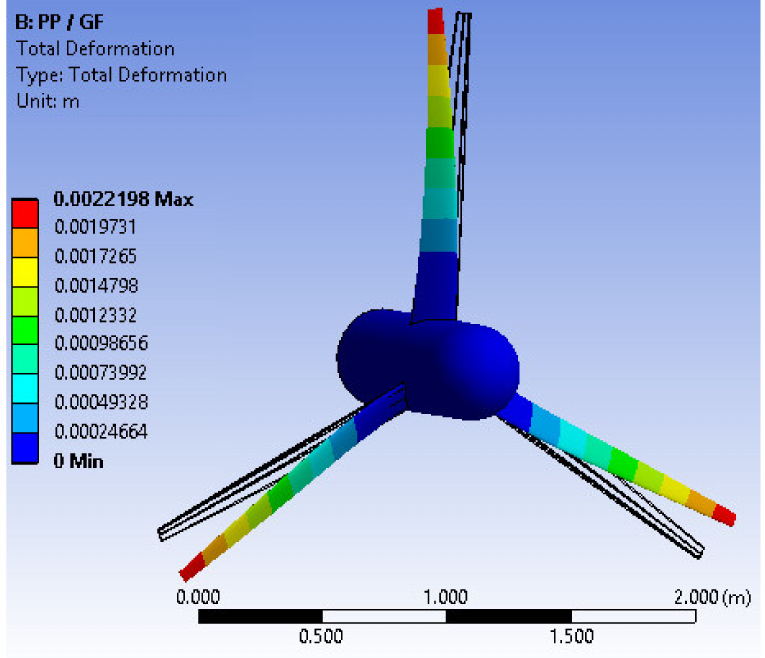
Figure 11. Graphical representation of maximum turbine blade deformation with PP/GF material at TSR =